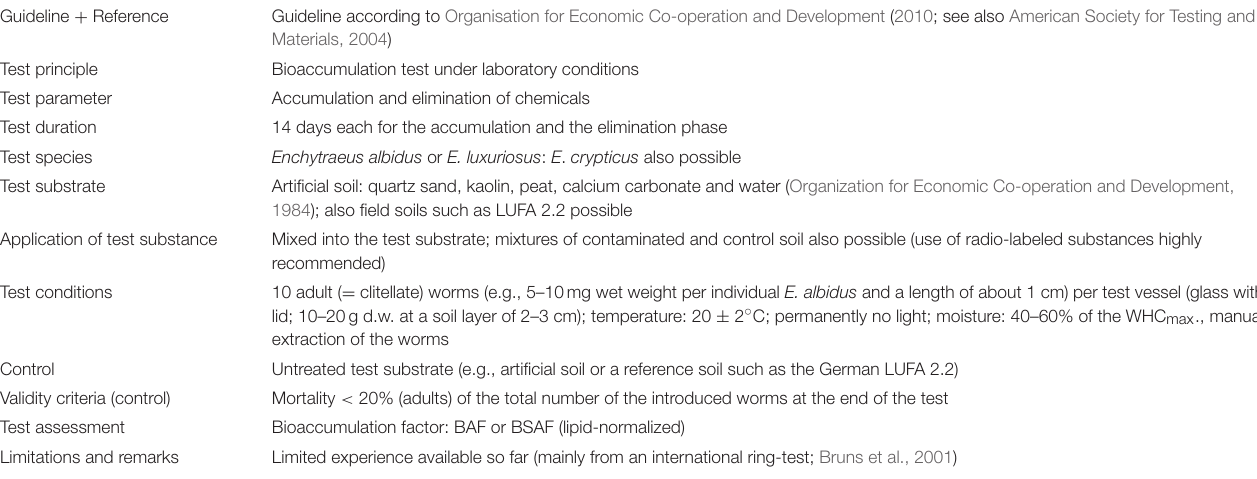
TABLE 3 | Overview of the properties of the Oligochaete Bioaccumulation Test (Organisation for Economic Co-operation and Development, 2010). Guideline +